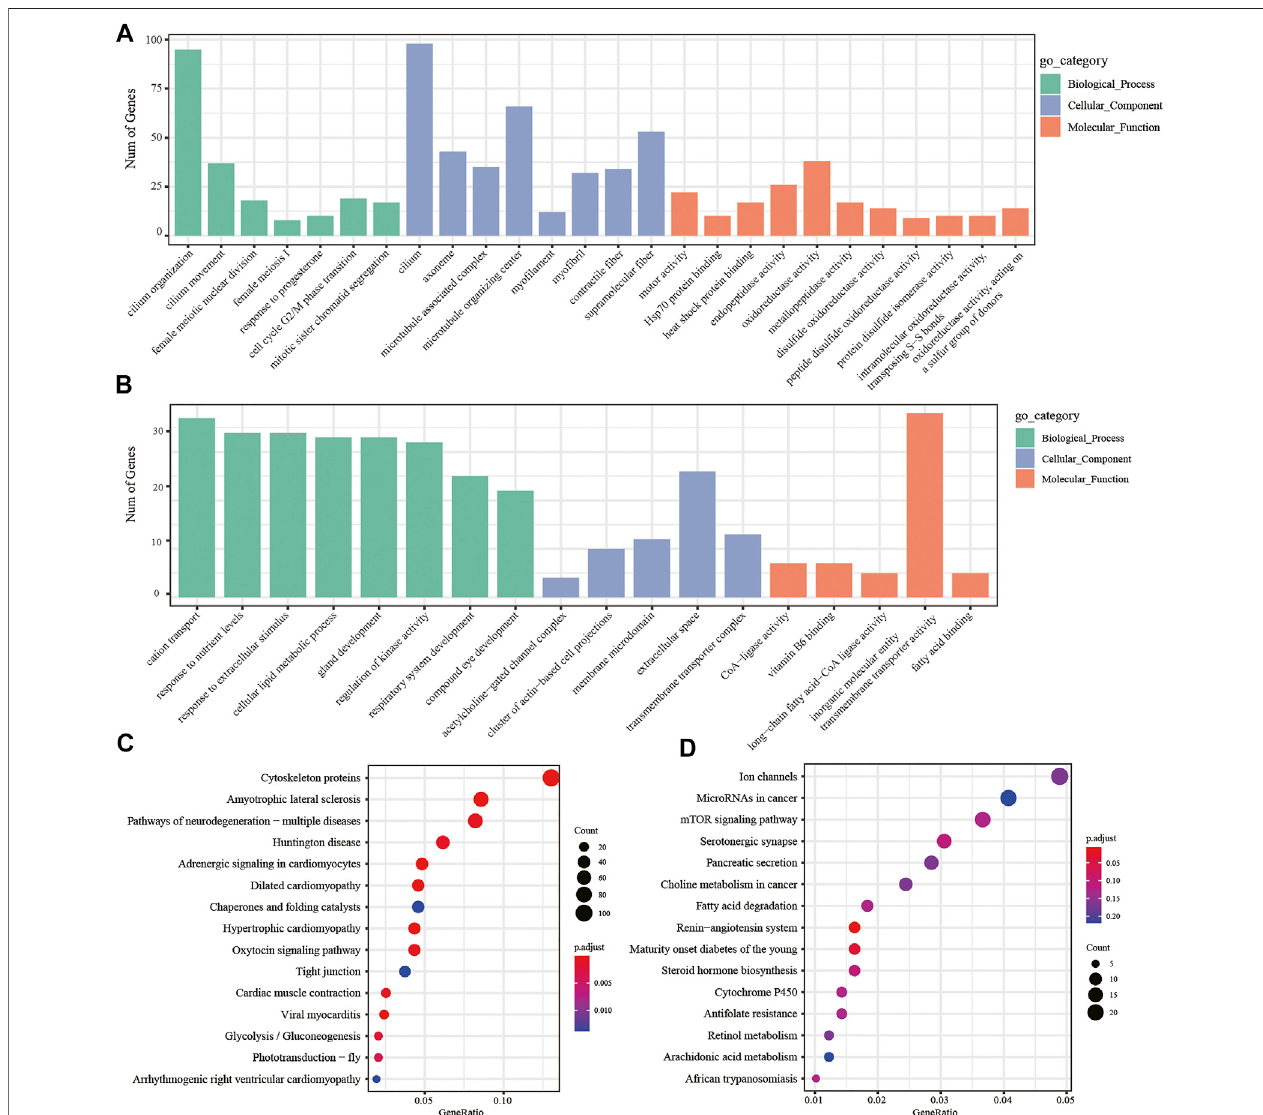
FIGURE 5 | DEG enrichment analysis in the LvsA period. GO enrichment analysis of (A) upregulated and (B) downregulated differential genes during the LvsA period; KEGG enrichment analysis of (C) upregulated and (D) downregulated differential expressed genes during LvsA period.